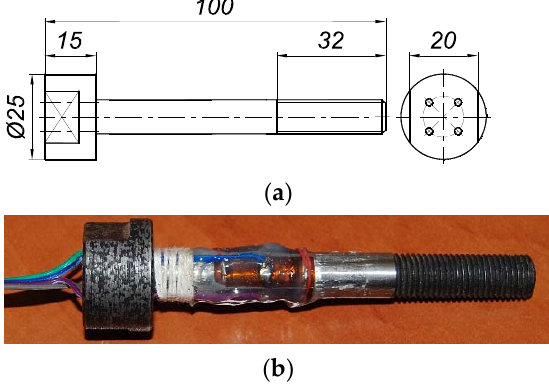
Figure 2. Single bolt used in tests: ( a ) diagram, ( b ) general view.